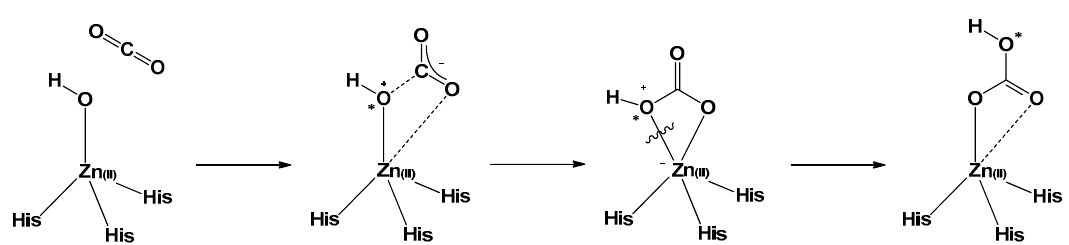
Figure 5. Mechanism for the formation of the bicarbonate intermediate, proposed by Lindskog.